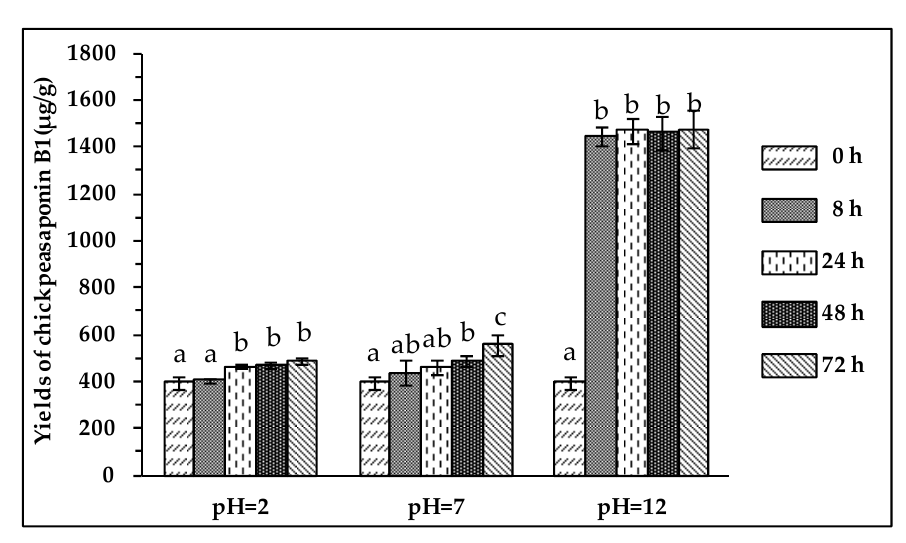
Figure 4. Effect of pH on the yields of target compound. Data are expressed as the mean value ± standard deviation (S.D.) of triplicate experiments. Data marked with different letters “a”, “b”, or “c” have significant differences, p < 0.05, while those marked with the same letter denote no significant difference, p > 0.05. Data marked with “ab” have no significant differences with those marked with “a” or “b”, p > 0.05, respectively.